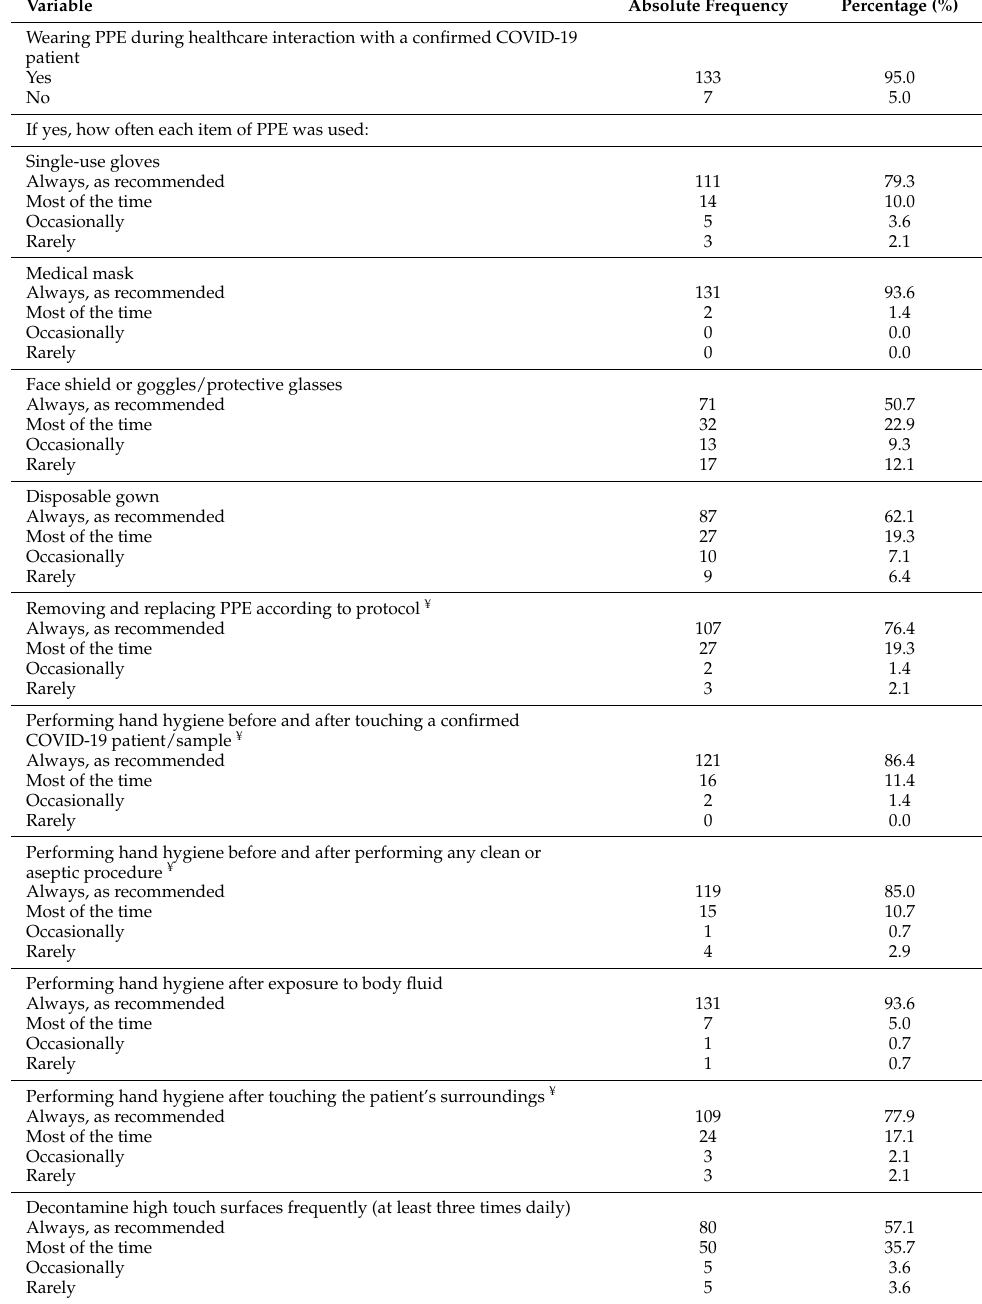
Table 3. Adherence to IPC procedures during healthcare